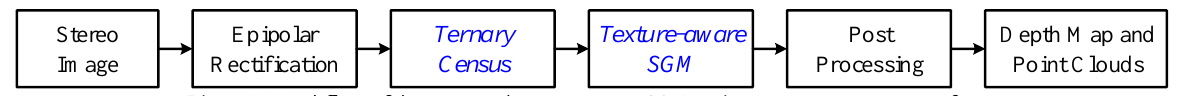
Figure 1. Workflow of the proposed texture-aware SGM using a ternary census transform.